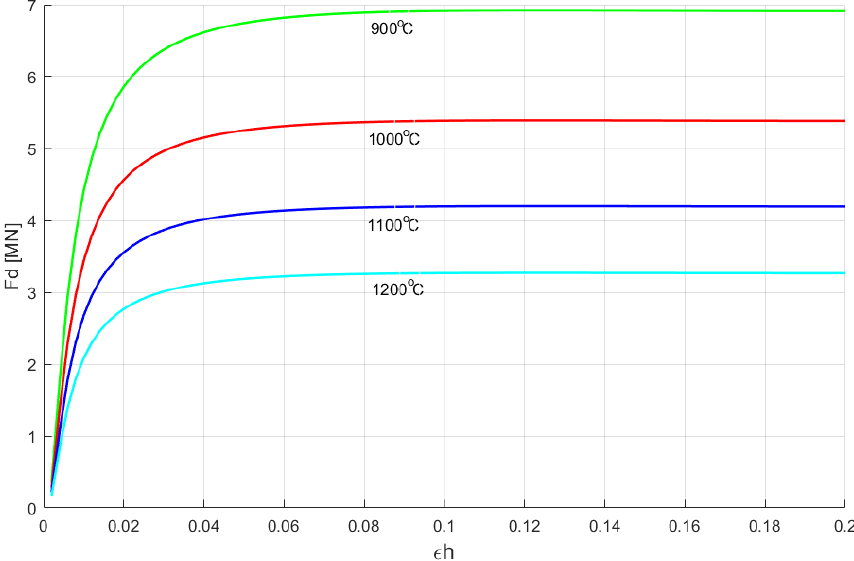
Figure 5. Curves of the predicted deformation force F d ( ε h ) for different strain rates 𝜑(cid:4662) and T = 900 °C